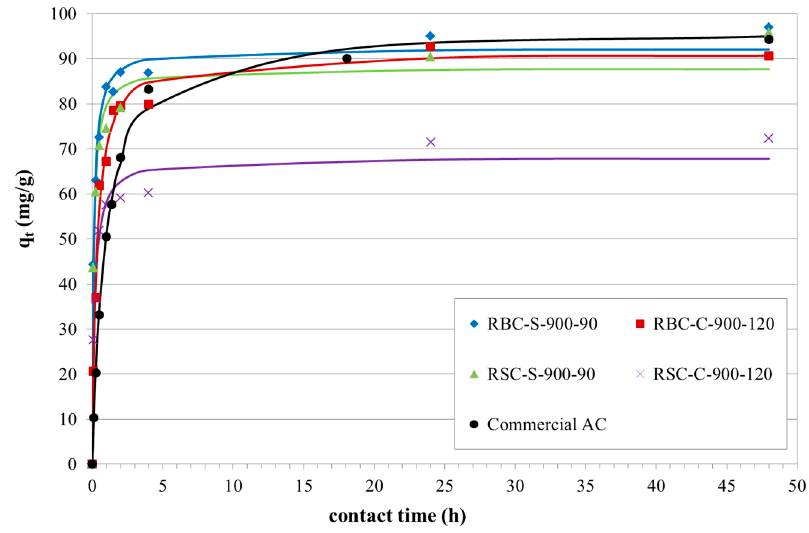
Figure 7. Phenol adsorption kinetic study (dots: experimental data; lines: fit of the PSO model) of the best performing ACs derived from RSC and RBC (C 0 = 100 mg/L).